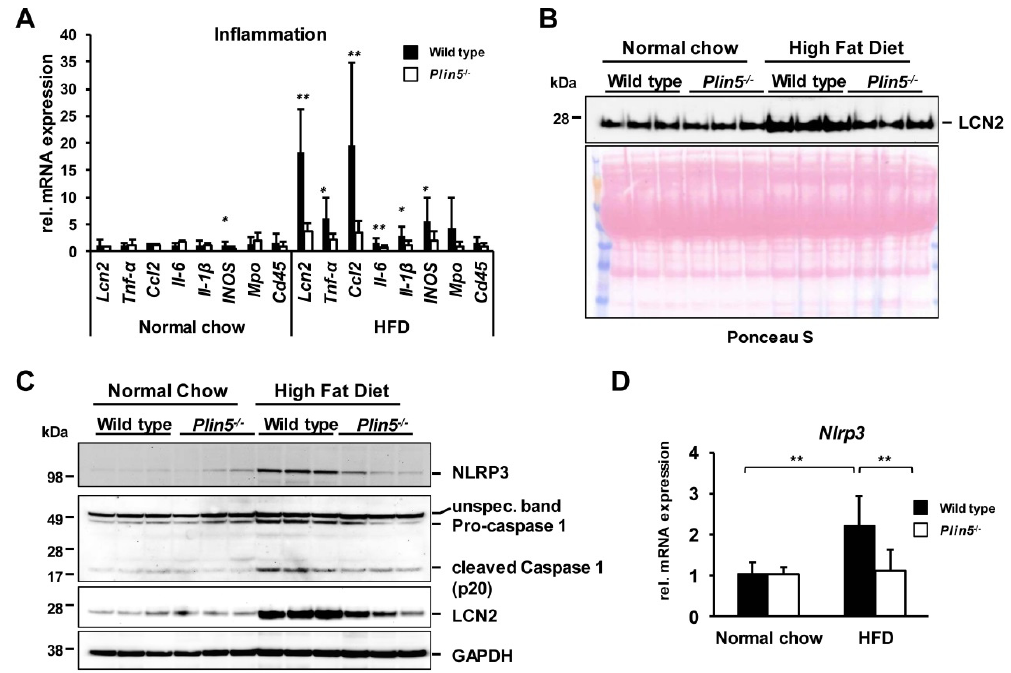
Figure 5. Suppression of Plin5 -mitigated inflammation via missing activation of the NLRP3 inflammasome. ( A ) mRNA levels of major cytokines and inflammatory markers induced in the wild type (WT) animals after 30 weeks on the high-fat diet (HFD) ( n = 4–7 animals/group). ( B ) Western blot of circulating pro-inflammatory marker Lipocalin 2 (LCN2) in serum of representative WT and Plin5 − / − mice after normal chow (NC) or HFD feeding. Ponceau S staining was used to demonstrate equal protein loading. ( C ) Western blot of protein levels of constituents of the inflammasome complex and LCN2 in WT and Plin5 − / − mouse livers after the NC or HFD administration. ( D ) Nrlp3 mRNA expression in mouse livers. Data in ( A ) and ( D ) are expressed as mean ± SD. Statistical analysis was performed with Student’s t -test. * p < 0.05; ** p < 0.01. 3.4. Lack of Plin5 Alleviates LPS-Induced Inflammasome Activation in Primary Hepatocytes by Suppressing